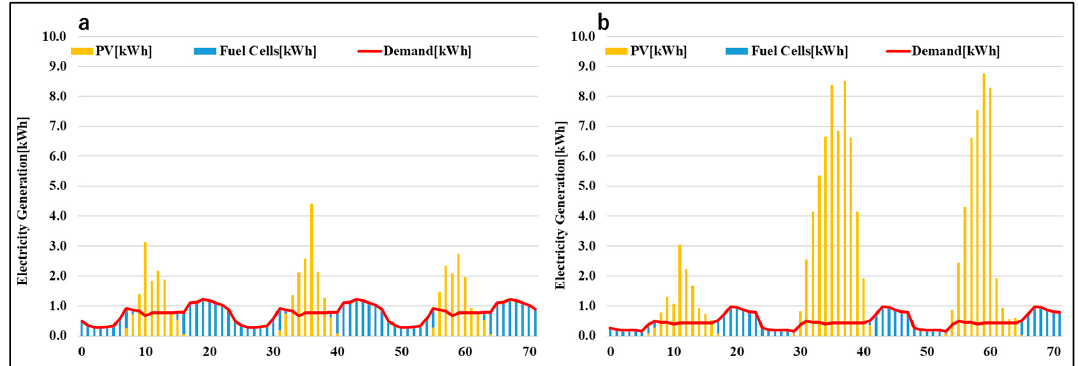
Figure 13. Hourly simulations of the electricity supply / demand in scenario 2: ( a ) January 1–January 4; ( b ) April 1–April 4.